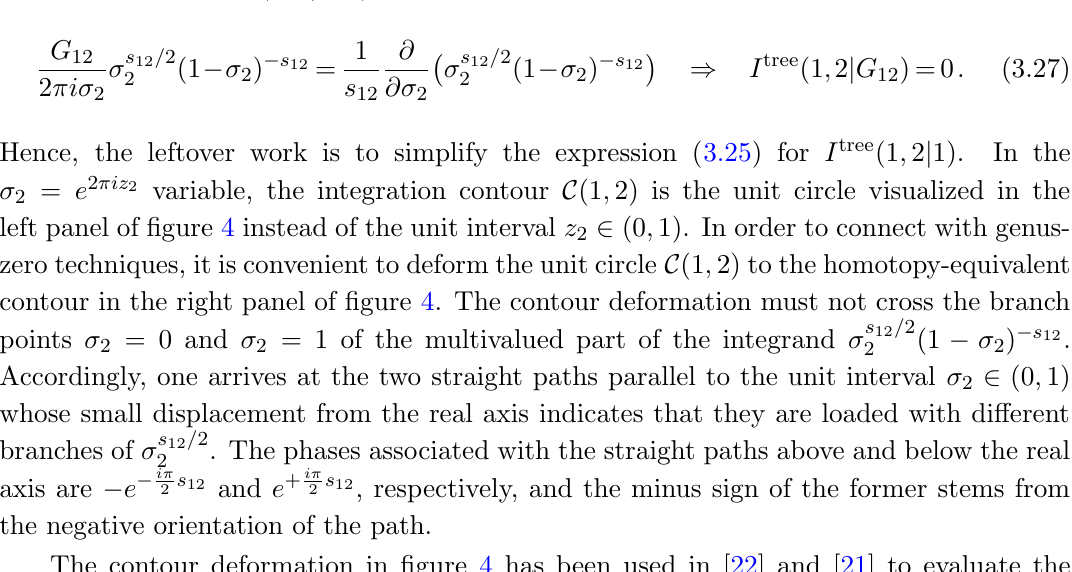
introduces phases e (cid:6) i(cid:25) 2 s 12 2